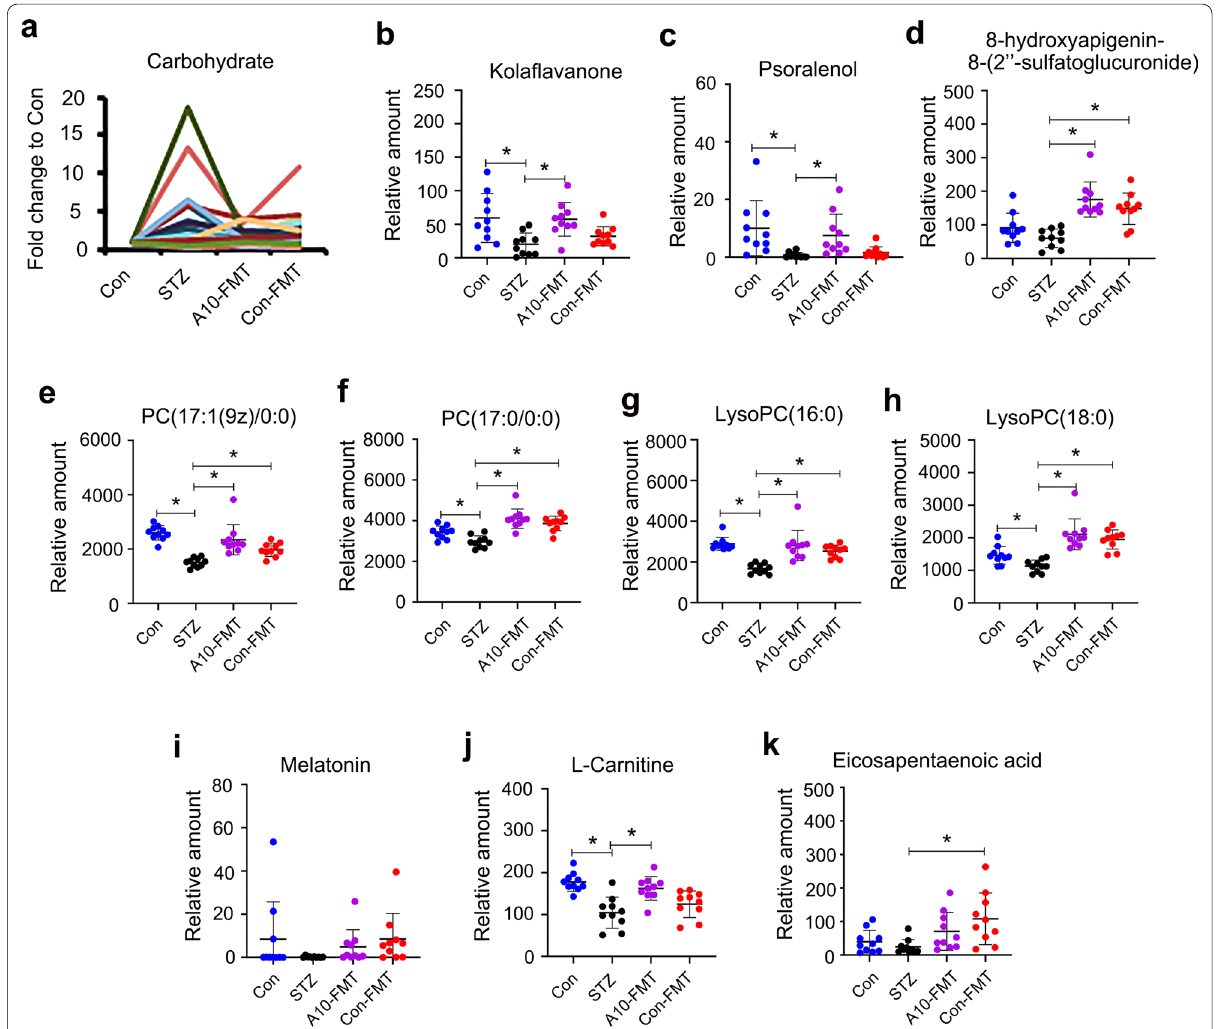
Fig. 3 A10-FMT improved blood metabolism. a Blood carbohydrate levels in different treatments. The y-axis represents the fold change compared to control group (Con). The x-axis represents the treatment. b Blood flavonoid Kola flavanone levels in different treatments. The y-axis represents the relative amount. The x-axis represents the treatment. * p < 0.05. c Blood flavonoid Psoralenol levels in different treatments. The y-axis represents the relative amount. The x-axis represents the treatment. * p < 0.05. d Blood flavonoid 8-hydroxyaplgenin 8-(2 ″ -sulfatoglucuronide) levels in different treatments. The y-axis represents the relative amount. The x-axis represents the treatment. * p < 0.05. e Blood PC (17:1(9z)/0:0) levels in different treatments. The y-axis represents the relative amount. The x-axis represents the treatment. * p < 0.05. f Blood PC (17:0/0:0) levels in different treatments. The y-axis represents the relative amount. The x-axis represents the treatment. * p < 0.05. g Blood LysoPC (16:0) levels in different treatments. The y-axis represents the relative amount. The x-axis represents the treatment. * p < 0.05. h Blood LysoPC (18:0) levels in different treatments. The y-axis represents the relative amount. The x-axis represents the treatment. * p < 0.05. i Blood melatonin levels in different treatments. The y-axis represents the relative amount. The x-axis represents the treatment. * p < 0.05. j Blood l -Carnitine levels in different treatments. The y-axis represents the relative amount. The x-axis represents the treatment. * p < 0.05. k Blood eicosapentaenoic acid (EPA) levels in different treatments. The y-axis represents the relative amount. The x-axis represents the treatment. * p < 0.05. n =